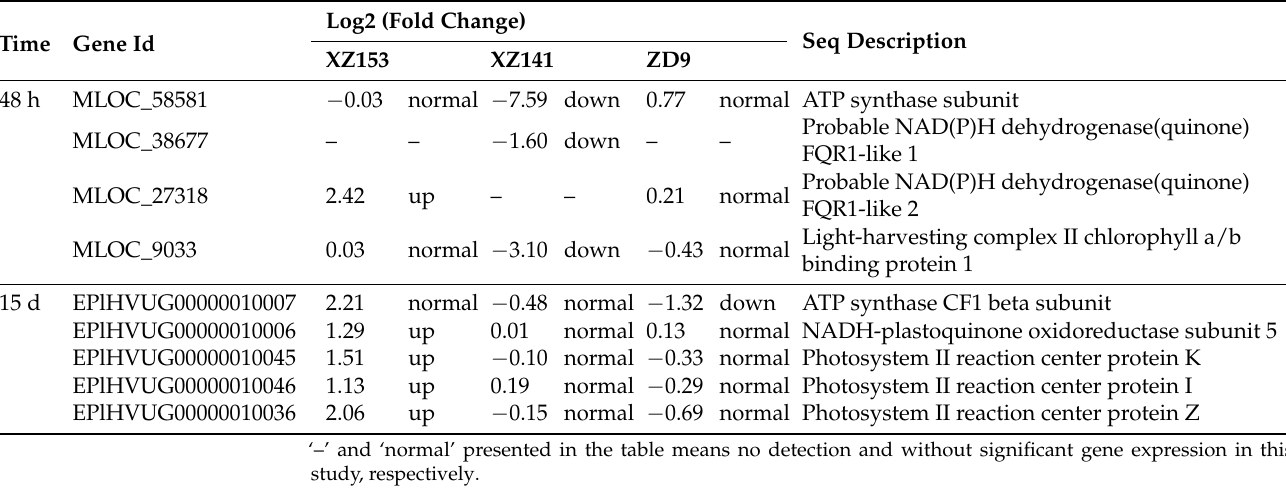
Table 5. The DEGs involved in four metabolic pathways at 48 h and 15 d after being exposed to LK stress.